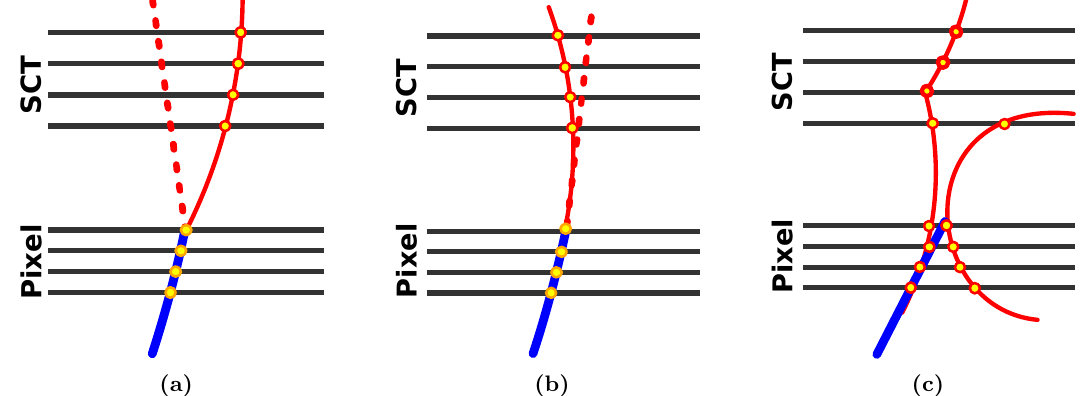
Figure 3 . Sketch of the di(cid:11)erent background components in the search with pixel tracklets. Thin solid and dotted red lines show trajectories of charged and neutral particles respectively. Thick blue lines show reconstructed pixel tracklets. (a) A hadron undergoing a hard scattering can yield track segments in the pixel and SCT detector that are not recognised as belonging to the same track, thus faking a pixel tracklet. (b) A lepton emitting hard photon radiation could be identi(cid:12)ed as a pixel tracklet through a similar mechanism. (c) A pixel tracklet can arise from a random combination of hits created by di(cid:11)erent particles in close